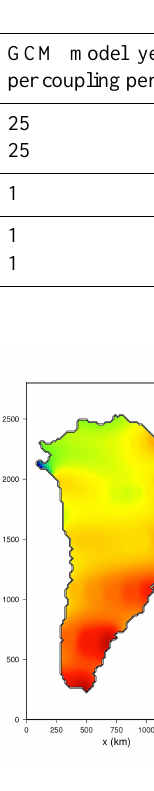
Figure 3. As Fig. 2, but for accumulation rates. Please note that the colour bar differs from the one in Fig. 2. Data base for (c) : Bamber et al.